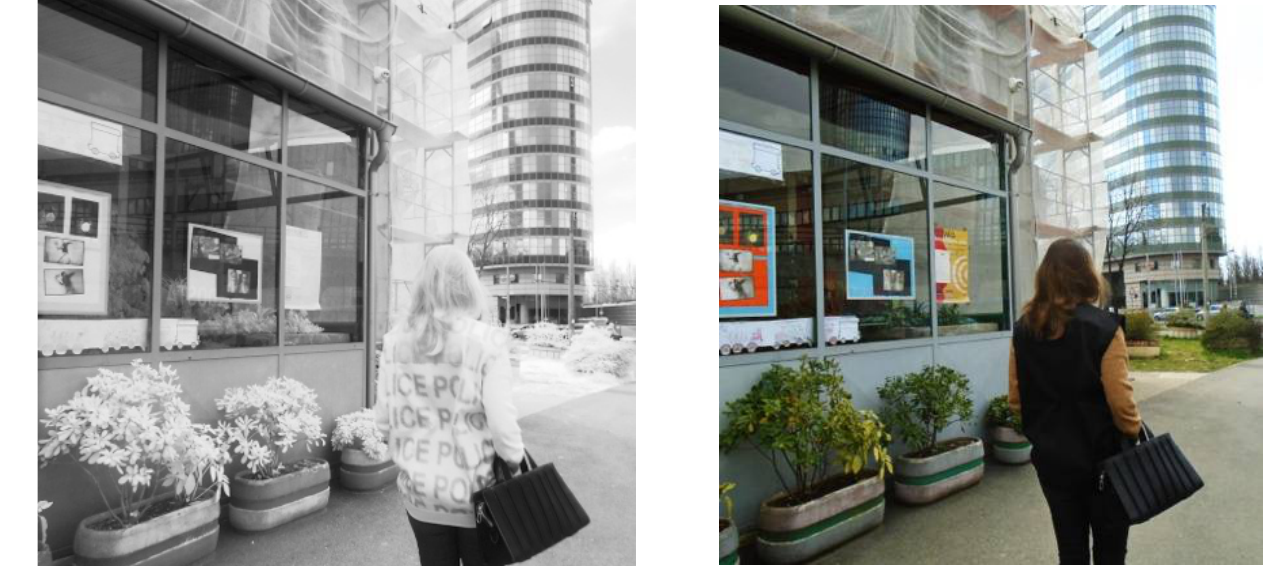
Figure 2. A boy on the street with a hidden mark (ZRGB camera).